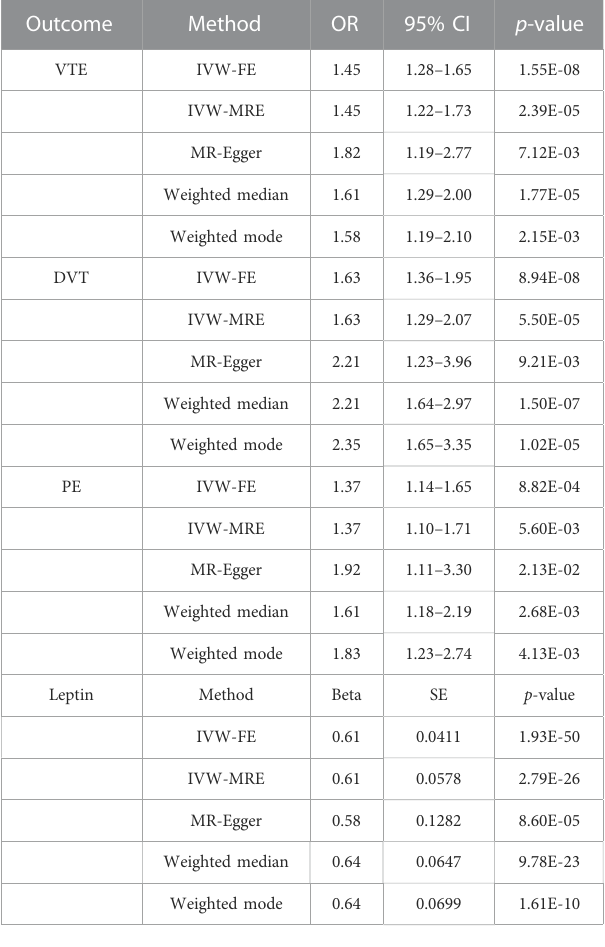
TABLE 4 Main result and sensitivity analysis of Mendelian randomization in BMI and VTE, DVT, PE, and leptin. Outcome